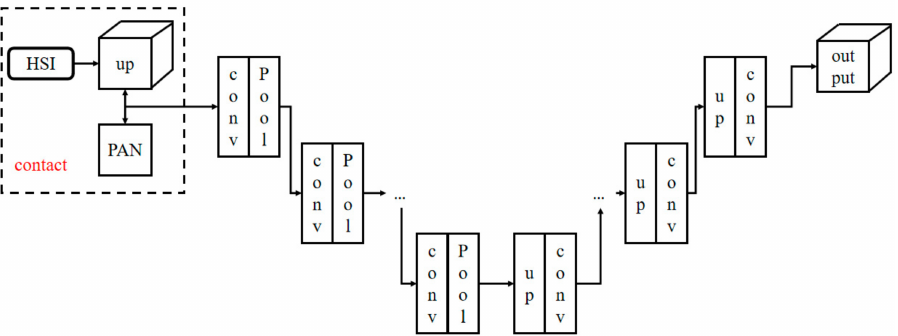
Figure 1. Schematic diagram of the encoder–decoder